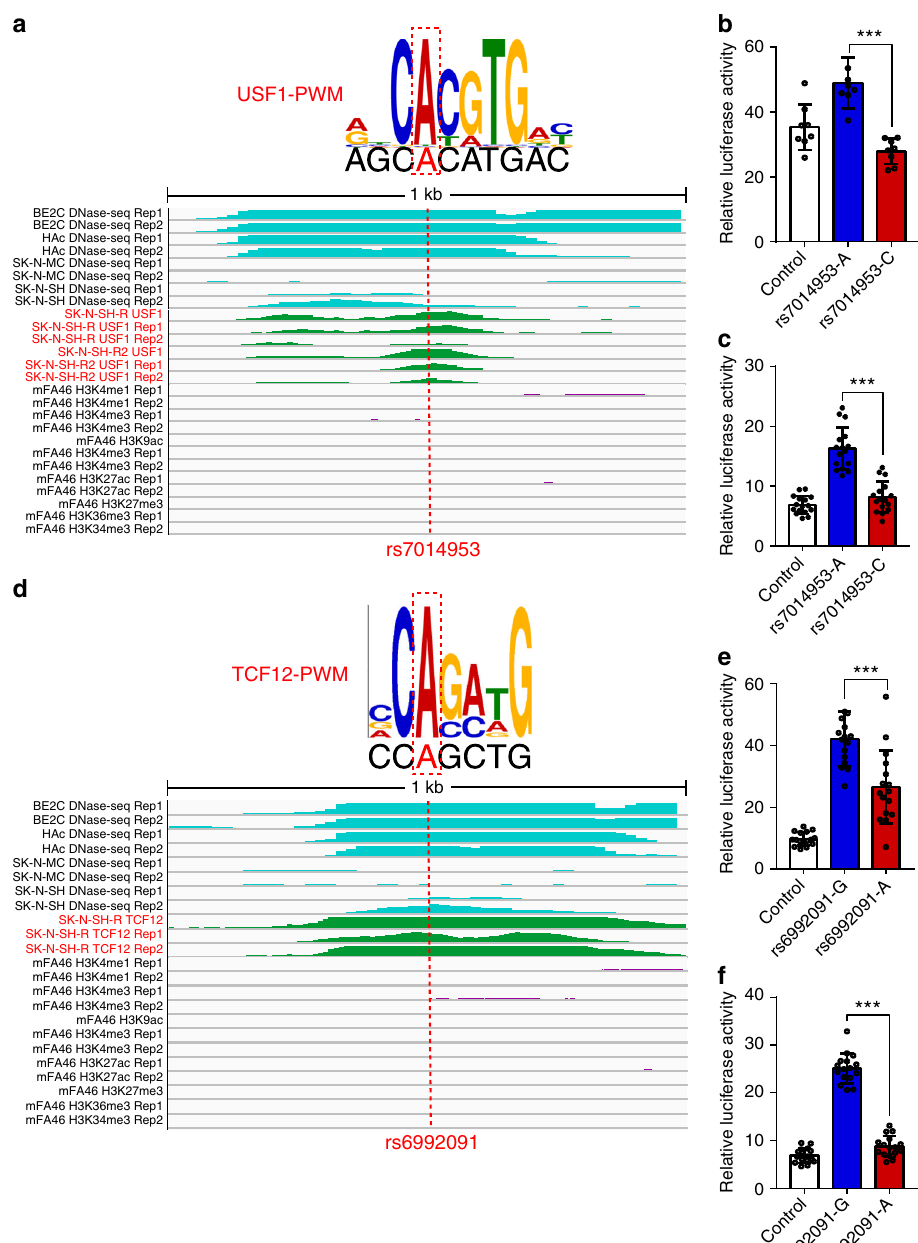
Fig. 7 Disruption of USF1 and TCF12 binding by risk single-nucleotide polymorphisms (SNPs) rs7014953 and rs6992091. a SNP rs7014953 is located in binding motif of USF1 and disrupts occupied USF1 binding site. The matched position weight matrix (PWM) and the location of rs7014953 (red dotted line) are shown. DNase-Seq and chromatin immunoprecipitation and sequencing (ChIP-Seq) experiments showed that rs12912934 overlaps with DNase-Seq and ChIP-Seq peaks, indicating that USF1 can bind to the genomic region containing rs12912934 in human brain tissues or neuronal cell lines. b , c Reporter gene assay showed that the construct containing A allele (of rs7014953) exhibited signi fi cant higher luciferase activity compared with the construct containing the C allele in SK-N-SH ( b ) and SH-SY5Y ( c ) cells. d SNP rs6992091 is located in the binding motif of TCF12 and disrupts occupied TCF12 binding site in human brain tissues or neuronal cell lines. Matched PWM of TCF12 and the location of rs6992091 are shown (with red dotted box). Genomic region (1 kb) surrounding SNP rs6992091 is shown with three featured visualization tracks, including DNase-Seq signal (light blue), ChIP-Deq signal (green) for TCF12 and histone modi fi cations (purple). The location of rs6992091 is highlighted with the dotted red line. e , f Reporter gene assay showed that the construct containing G allele (of rs6992091) exhibited signi fi cant higher luciferase activity compared with the construct containing the A allele in SK-N-SH ( b ) and SH-SY5Y ( c ) cells. Data represent mean ± SD; n = 8 for each group in b (SK-N-SH cells) and n = 16 for each group in c , f (SH-SY5Y cells) and e (SK-N-SH cells). *** P < 0.001, two-tailed Student ’ s t- test. Source data are provided as a Source Data fi